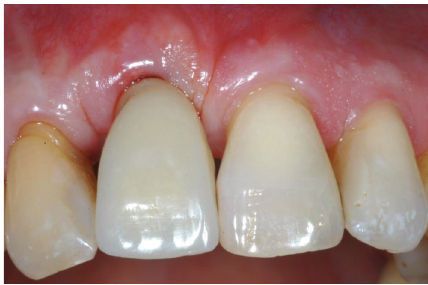
Figure 18: The acrylic resin provisional restoration in position.